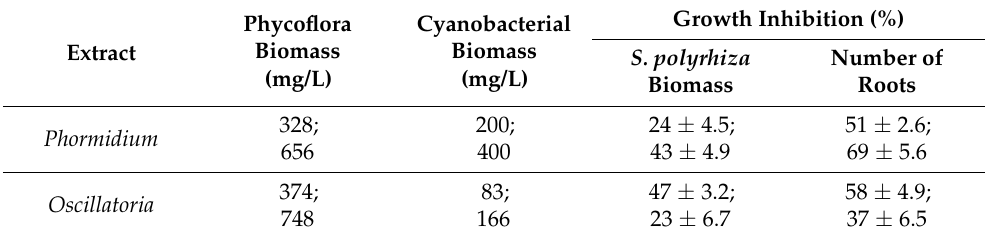
Table 2. Comparison of toxic effects of two the highest concentrations of the extracts obtained from similar phycoflora biomass and different cyanobacterial biomasses on S. polyrhiza, showing the importance and dependence of the effects observed on the concentration of cyanobacterial